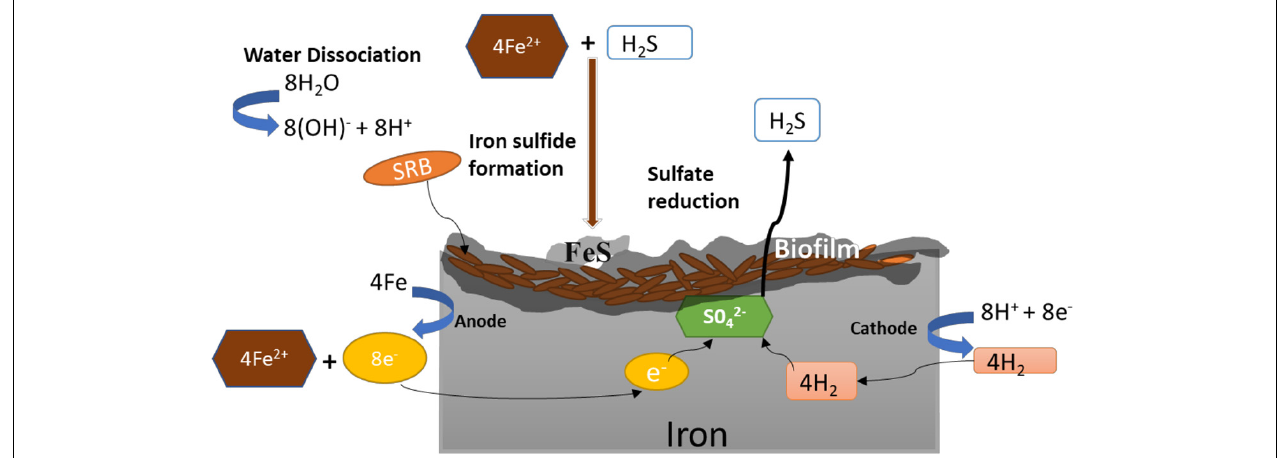
FIGURE 3 | Mechanism of microbiologically influenced corrosion (MIC) of iron by sulfate-reducing bacteria.